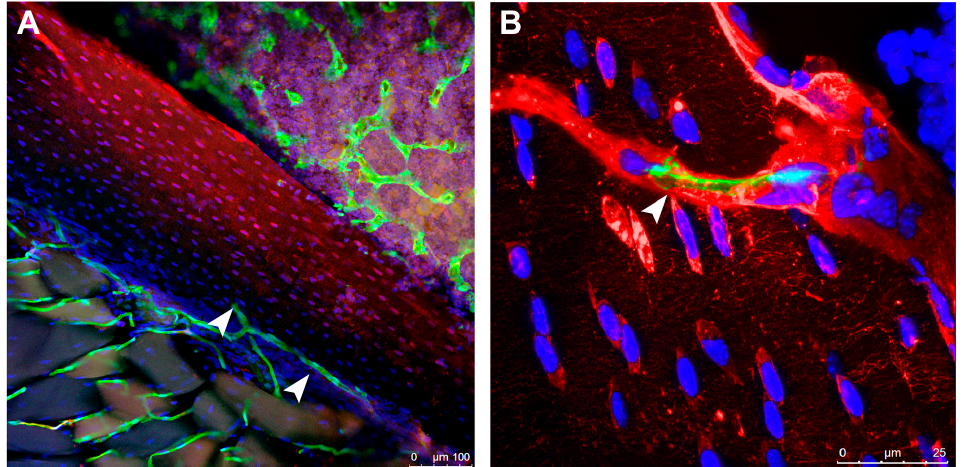
Figure 2. Role of vessels in the muscle–bone crosstalk: ( A ) Presence of vessels coming from the skeletal muscle in bone (white arrowheads). The vessels are stained in green, in transgenic mice model Flk1-GFP, where the green fluorescent protein is driven by a promoter targeting a receptor of VEGF-A [50]. Magnification: 10×; ( B ) physical connection between osteocytes in the femur (stained in red by a Dextran-lysine fixable stain) and a vessel, in green (Flk1-GFP mice) (white arrowhead). Magnification: 63×. Scale bars represent: 100 μ m ( A ); and 25 μ m ( B ).